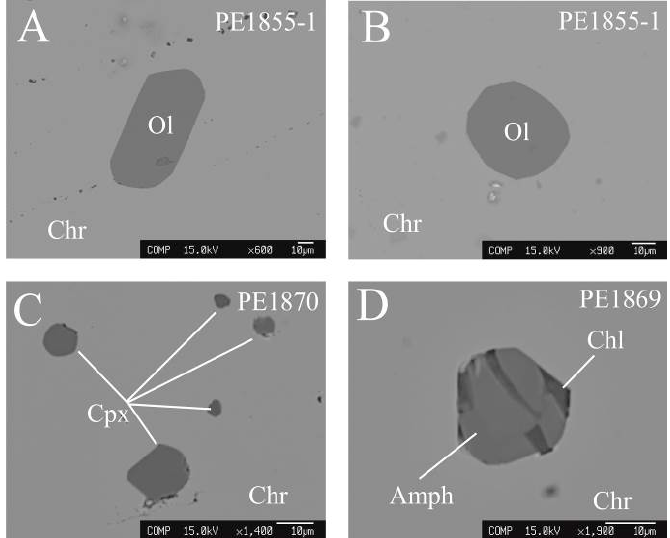
Figure 11. Binary diagram of P versus Ni + (Fe), apfu (atoms per formula unit), showing the composition of the Ni-phosphide found in the Bakanov Kluch chromitite (black square), compared with those of the minerals with Ni > Fe described in the system Ni–Fe–P (open squares). Literature data from [25–28].